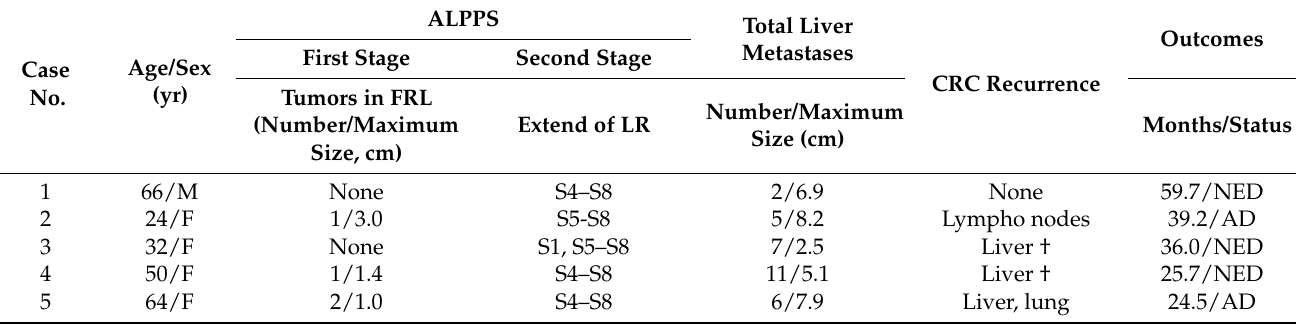
Table 3. Clinical features of patients underwent